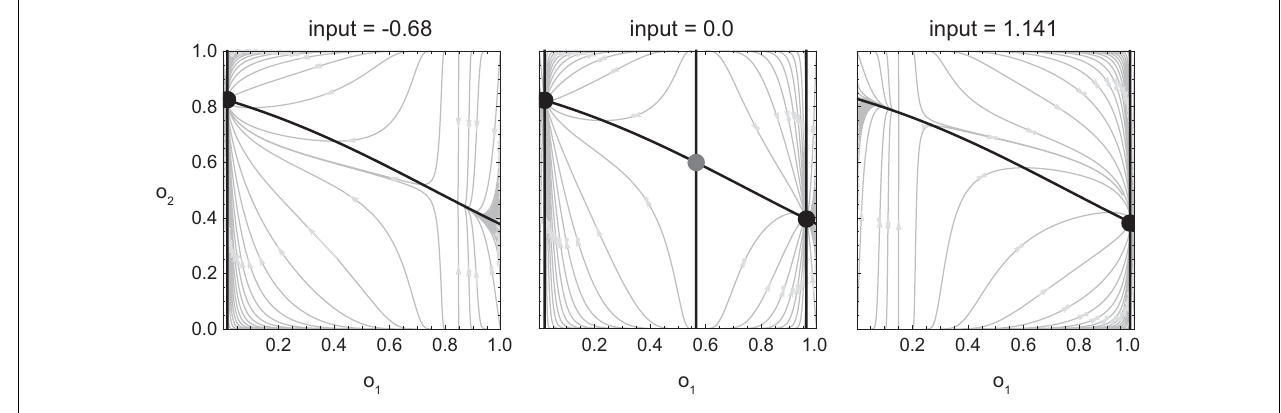
intersection of which can be found the fixed-point attractors (black dots) and saddle node (gray dots). In light gray the flow of trajectories toward the fixed points is shown.